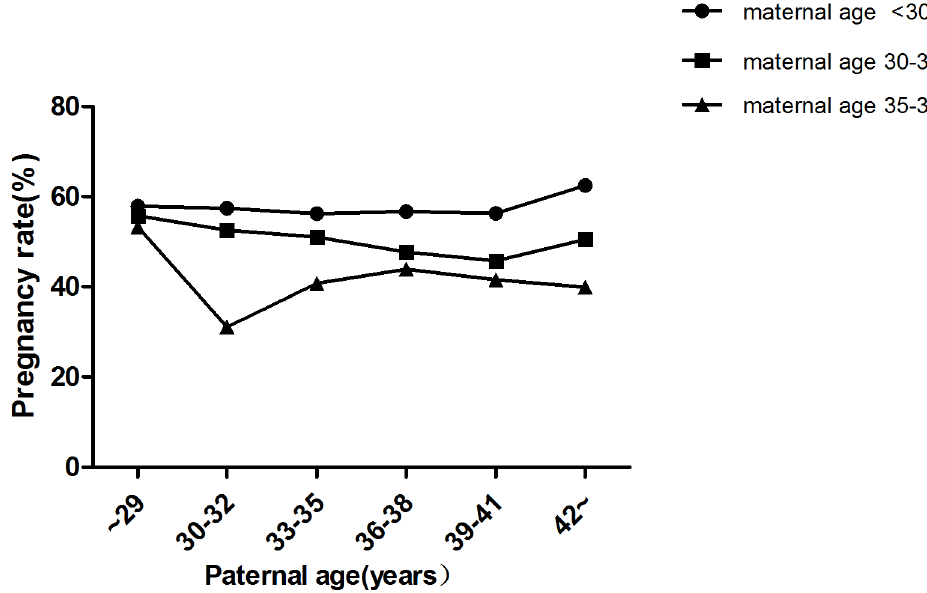
Fig 5. Pregnancy rates in different age groups. There were no significant differences in pregnancy rate among the different paternal age groups when the maternal age was < 30 y and 35 – 38 ( P > 0.05). In the 30 – 34 y maternal age group, the pregnancy rates significantly decreased with increasing paternal age ( P <